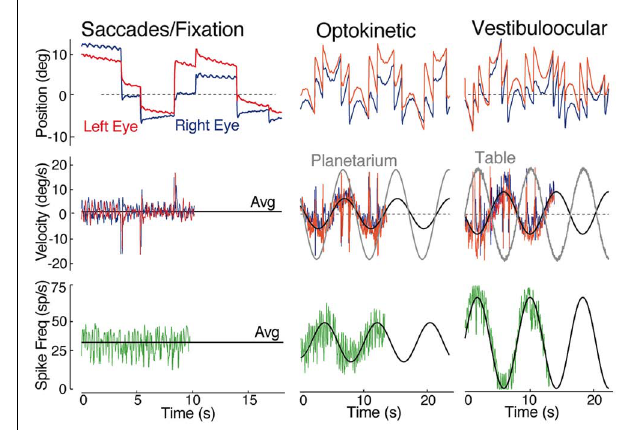
| Spontaneous, visual and vestibular-evoked horizontal eye movements in adult goldfish. Eye position (top row) and eye velocity (middle row) of the right (blue trace) and left eye (red trace) with the correlated discharge of a vestibular neuron (bottom row) during spontaneous saccades with periods of fixation, horizontal sinusoidal optokinetic stimulation (planetarium), and vertical axis sinusoidal head rotation (vestibuloocular); the black line indicates the average (Avg) eye velocity (middle row); and neuronal firing rate. Data were adapted from Green etal.